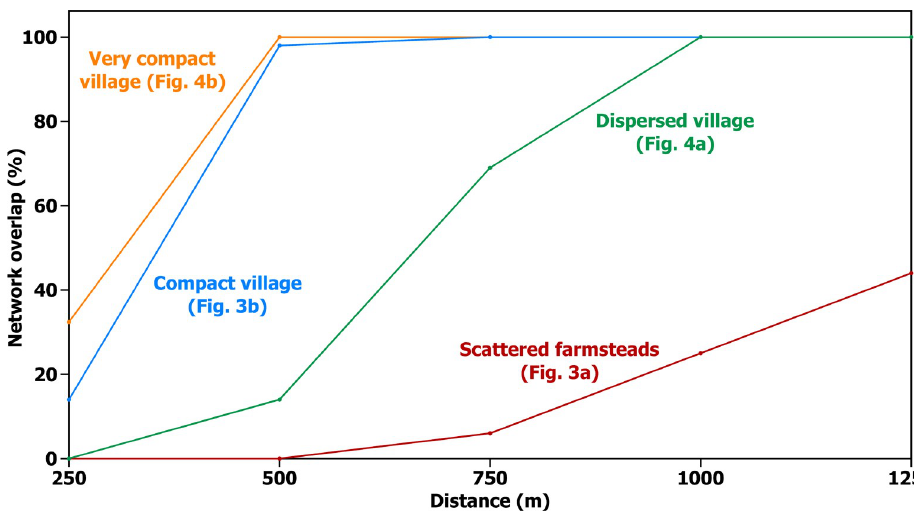
Fig 8. Network overlap. Overlap of interaction networks of Houses 1 and 2 (Fig 6) at varying distances (expressed as a proportion of total population).